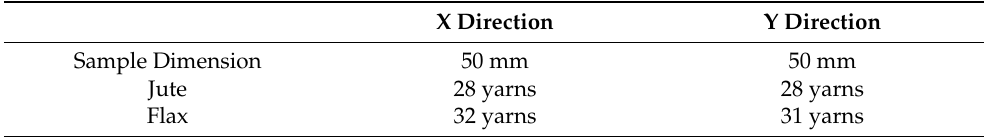
Table 1. Geometric characteristics of the flax and jute textile. X Direction Y Direction Sample Dimension 50 mm 50 mm Jute 28